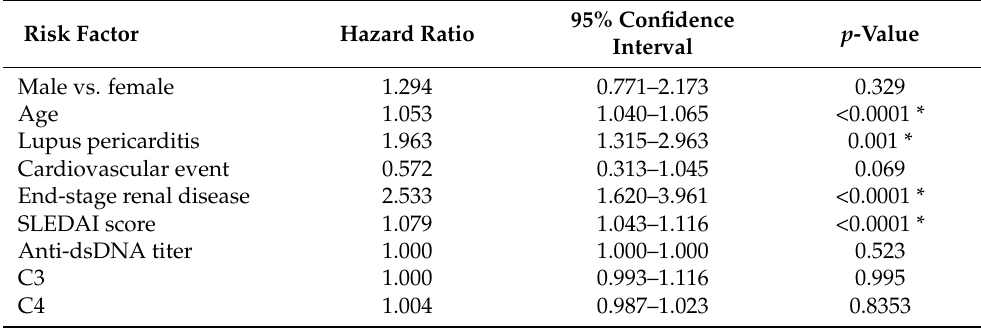
Table 2. Multivariate Cox regression analysis: adjusted hazard ratio of the risk factors for mortality in SLE patients.